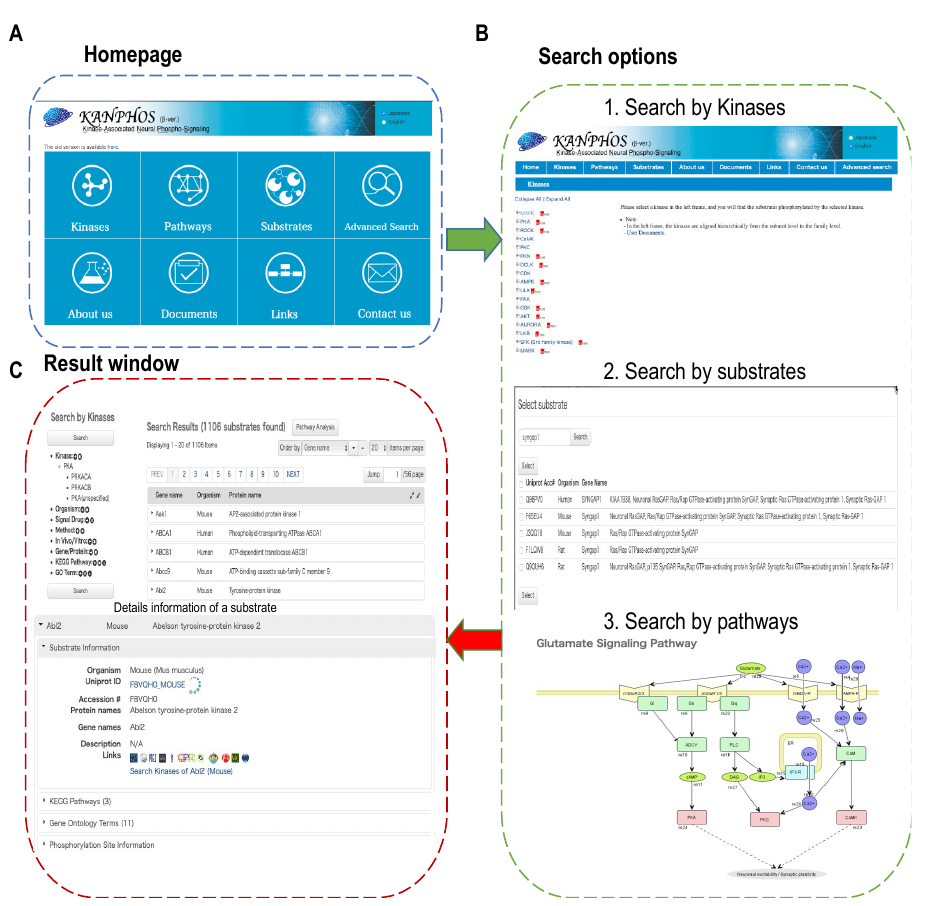
Figure 3. Overview of the KANPHOS workflow. ( A ) Homepage and browse function; ( B ) Simple search options (1) Search by kinases,(2) Search by substrates, and (3) Search by pathways; ( C ) Result window containing information about the phosphorylation sites, possible upstream signal and kinase.